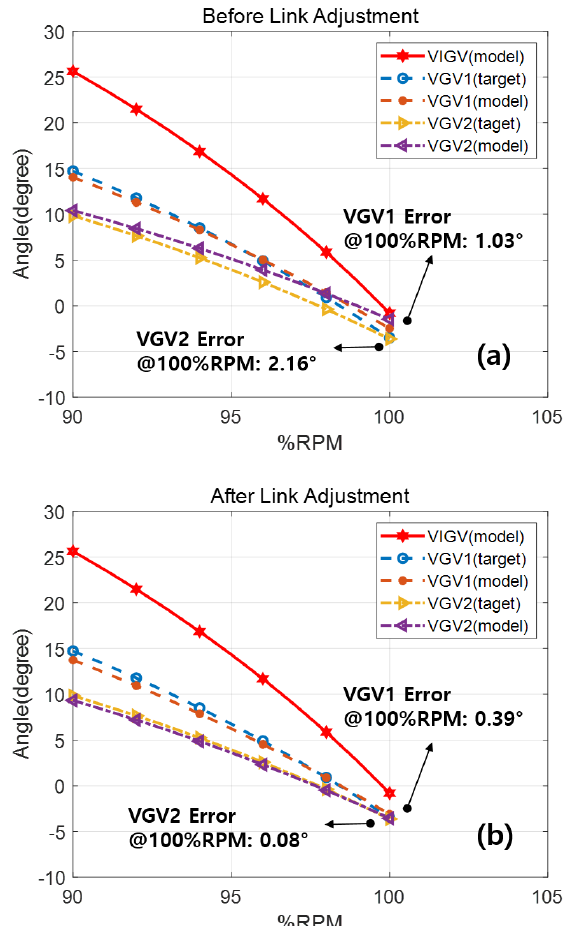
Figure 12. Scheduling results. ( a ) before link adjustment, ( b ) after link adjustment.